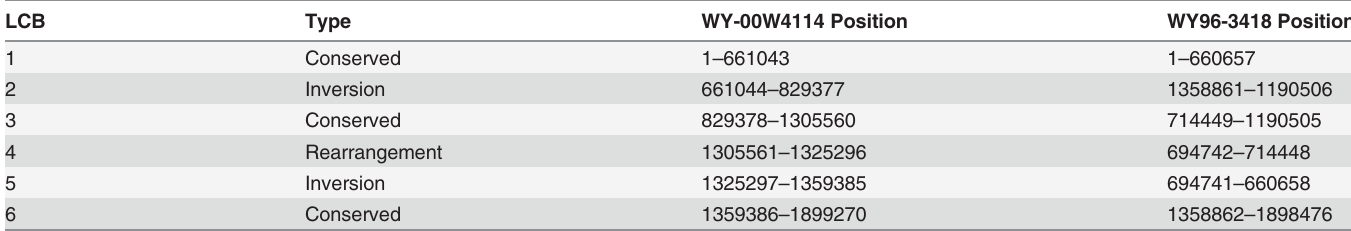
Table 2. Description and nucleotide position of locally collinear blocks (LCBs) within A.II strains WY-00W4114 and WY96-3418.